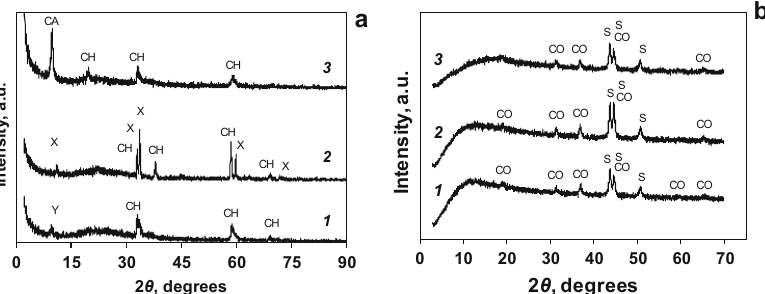
Fig. 1 XRD patterns of as-deposited ( a ) and annealed at 673 K ( b ) cobalt (hydro)oxide films, electrodeposited using different cobalt precursors: 1 cobalt nitrate, 2 cobalt chloride, 3 cobalt